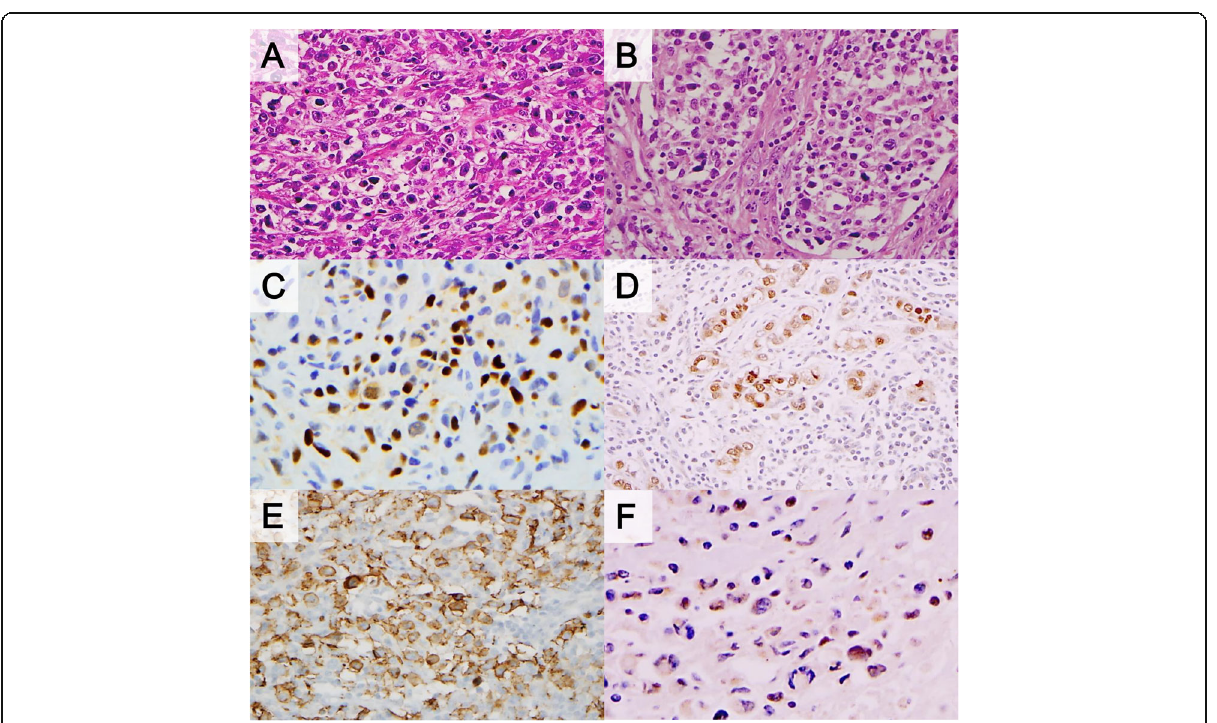
Fig. 2 Pathologic findings of primary mediastinal large B-cell lymphoma. Reticular fibrosis ( a ) or alveolar type tumor aggregates ( b ) is characteristic. Expression of p63 ( c ), bcl-6 ( d ), and CD23 ( e ) were significantly higher than that of classic Hodgkin lymphoma. Minority of cases showed focal positivity for cyclin E